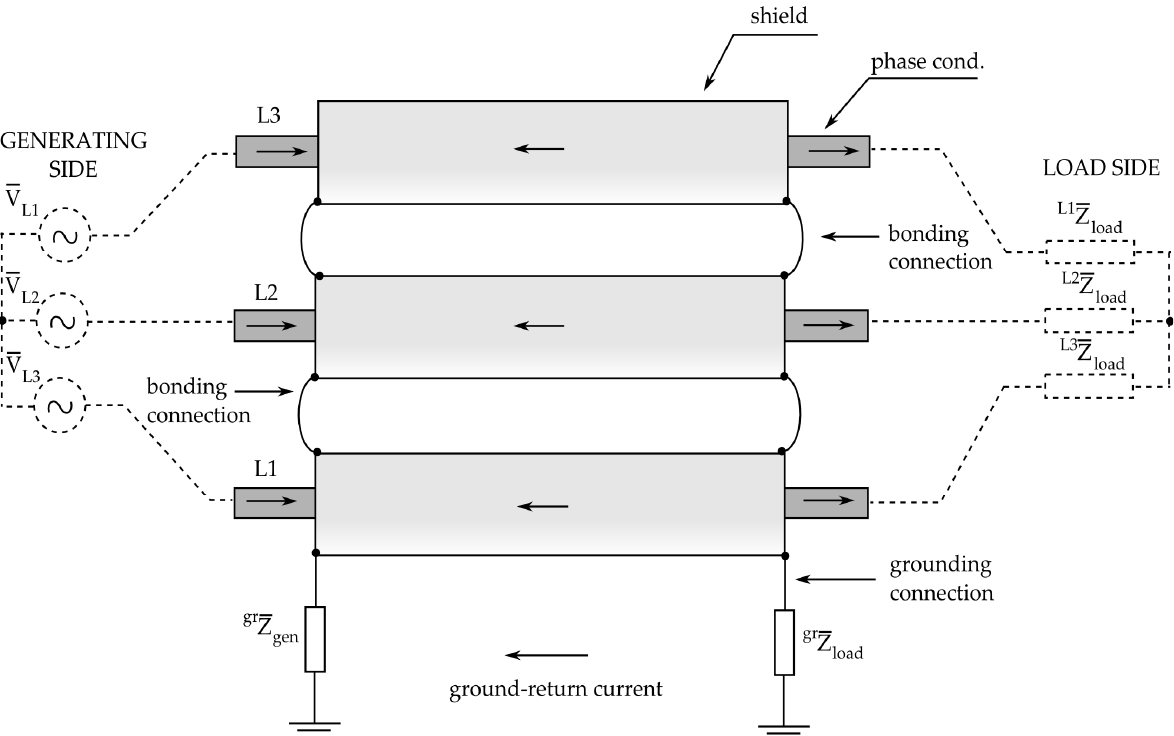
mutually bonded and grounded on both